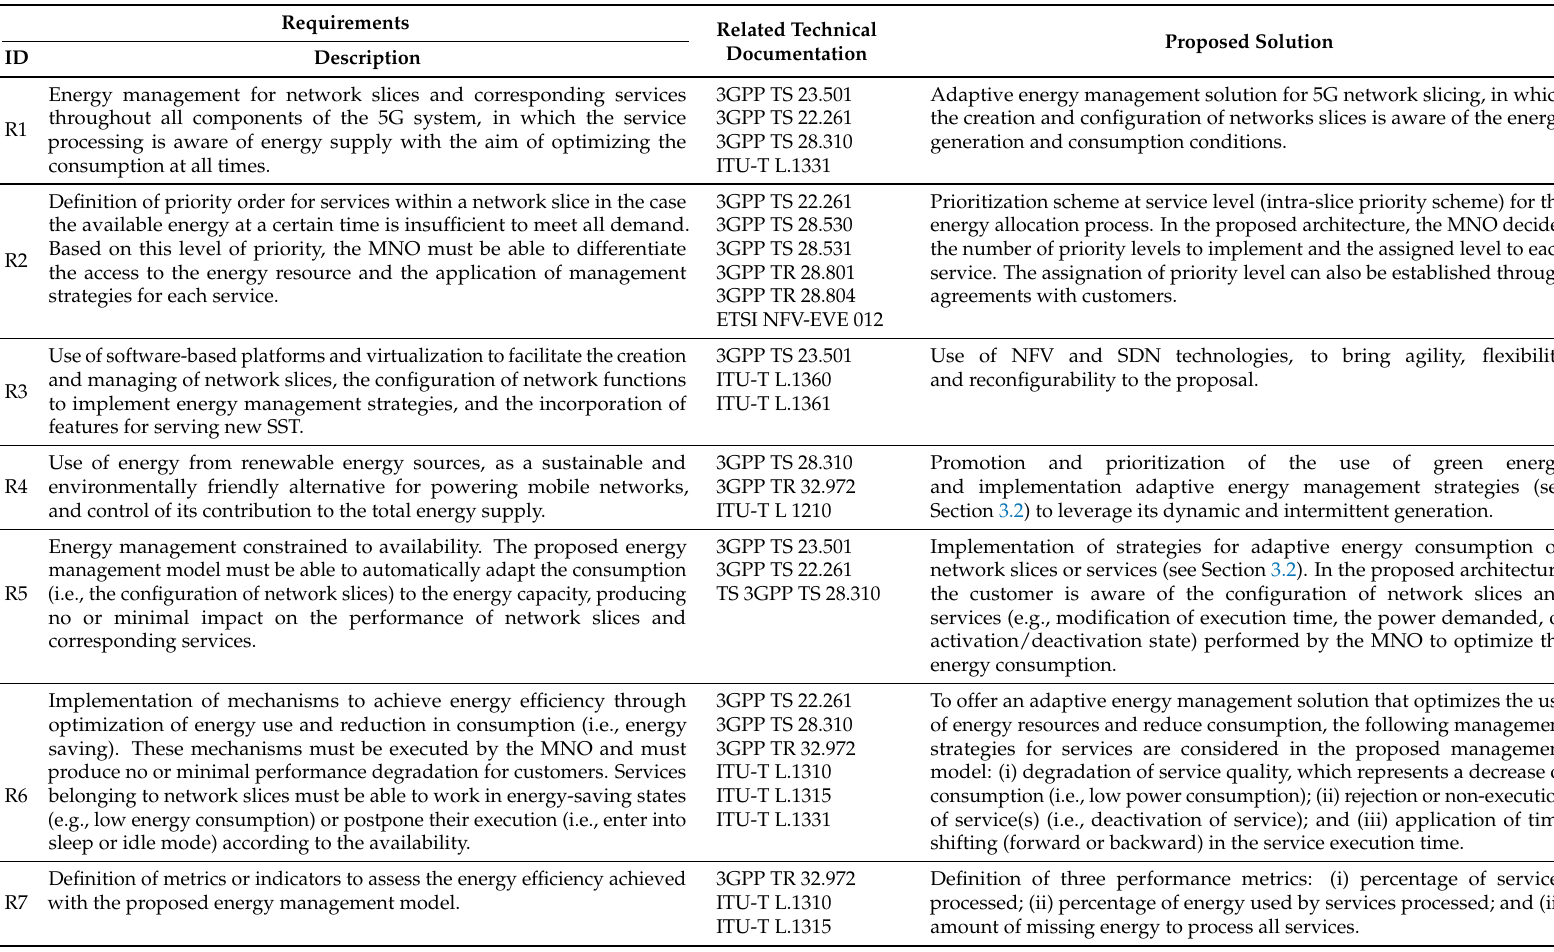
Table 4. Requirements and proposed solutions for adaptive energy management in 5G Network